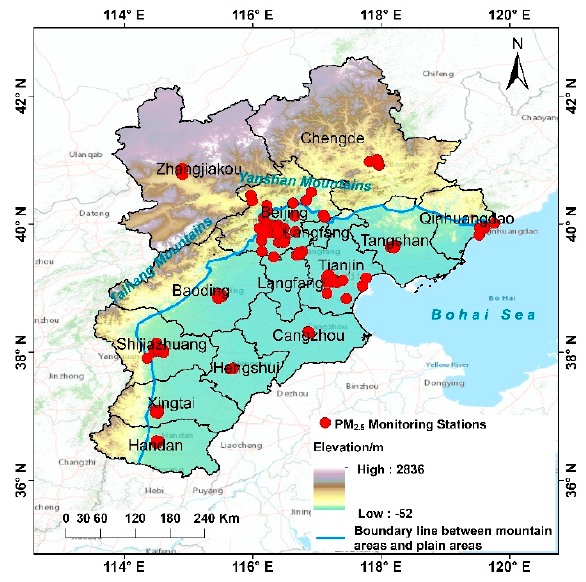
Figure 1. Map of the study area (the mountain areas and plain areas are divided by the blue color line).